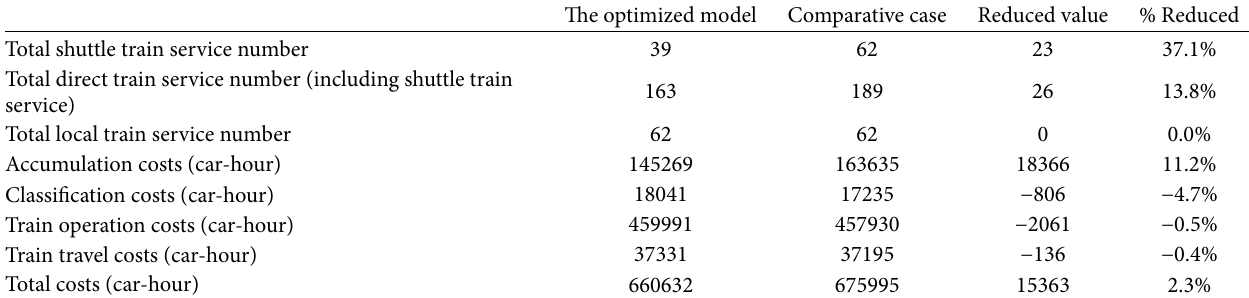
Table 9: Composition of the objective function of each